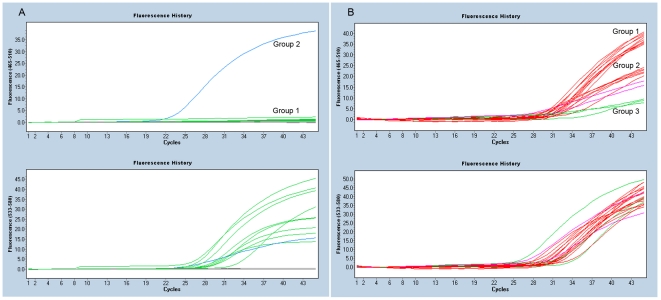
qPCR Results for the EGFR assays.Panel A shows the EGFR p.L858R assay. All samples show a wild type (control) signal, VIC, lower panel (green and blue lines) while only group 2 (blue line) shows a mutant FAM signal. Panel B shows the EGFR exon 19 mutation assay. The lower panel shows the wildtype VIC signal for all samples (red, green and purple lines). The top panels shows the mutant FAM signal. Group 1 (red lines) shows the wildtype signal, Group 2 (red and purple) shows possible mutants with decreased fluorescence, group 3 (green line) show an almost completely disappeared signal indicating a deletion. The images are obtained from the LC480 software release 1.5.0. The y-axis shows the relative fluorescence for the FAM (465–510 nm) and VIC (533–580nm) probes, x-axis shows the PCR cycles.